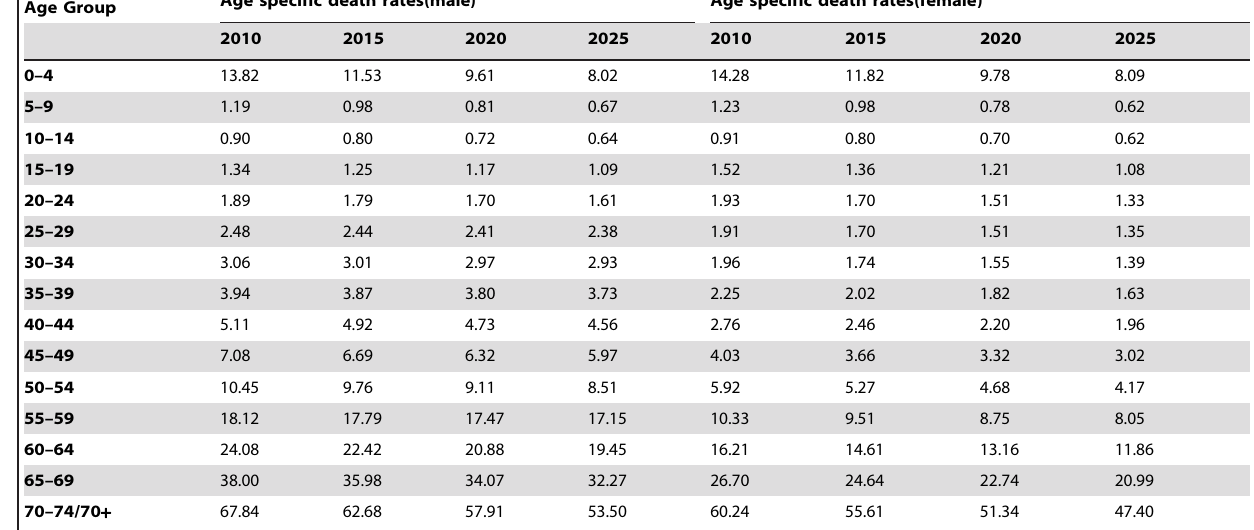
Age Group Age specific death rates(male)